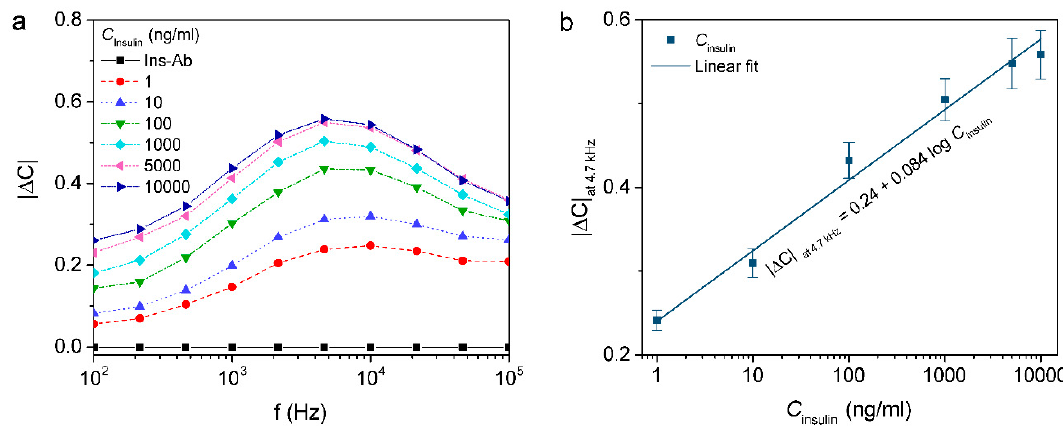
Figure 5. ( a ) Normalized capacitance ( |∆C| ) measured with respect to the concentration of insulin diluted in PBS; ( b ) |∆C| at 4.7 kHz for insulin concentrations ranging from 1 ng/mL to 10 µg/mL.